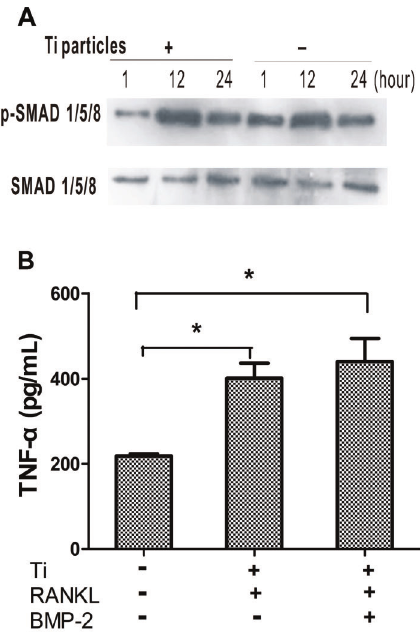
Figure 8. Titanium (Ti) particles do not affect phospho-SMAD (p-SMAD) 1/5/8 expression. BMP-2 does not affect expression of TNF- a . A , RAW 264.7 cells were treated with 30 ng/mL RANKL and 50 ng/mL BMP-2 for 1 h, then treated with or without 150 m g/mL Ti particles at indicated times. B , ELISA showed the expression of TNF- a . RAW 264.7 cells (control) were treated with 30 ng/mL RANKL and 150 m g/mL Ti particles for 1 h, then treated or not with 50 ng/mL BMP-2 for 24 h. Data are reported as means±SD. *P , 0.05 (one-way ANOVA).